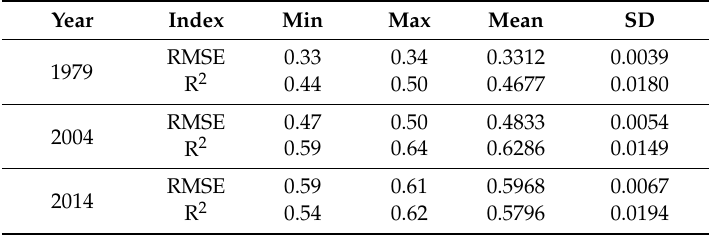
Table 4. Summary statistics of the RF performance in predicting the soil TN distribution with 100